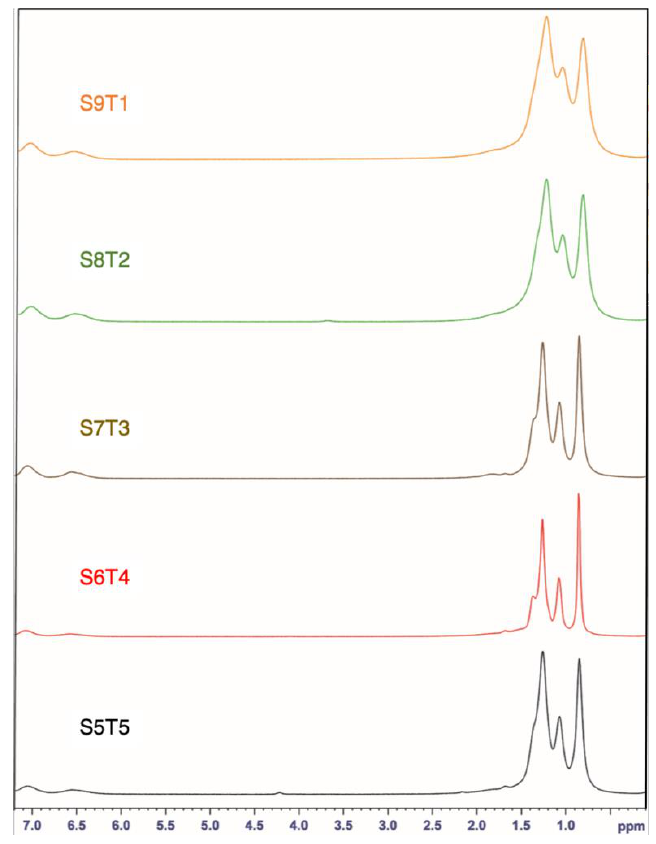
Figure 2. 1 H-NMR spectra of different SIS copolymers after hydrogenation. The DS for sulfonated samples sS5T5, sS6T4, sS7T3, sS8T2, and sS9T1 were 2.82 ± 0.29%, 1.68 ± 0.11%, 2.59 ± 0.28%, 0.78 ± 0.14%, and 1.10 ± 0.32%, respectively. Statistical